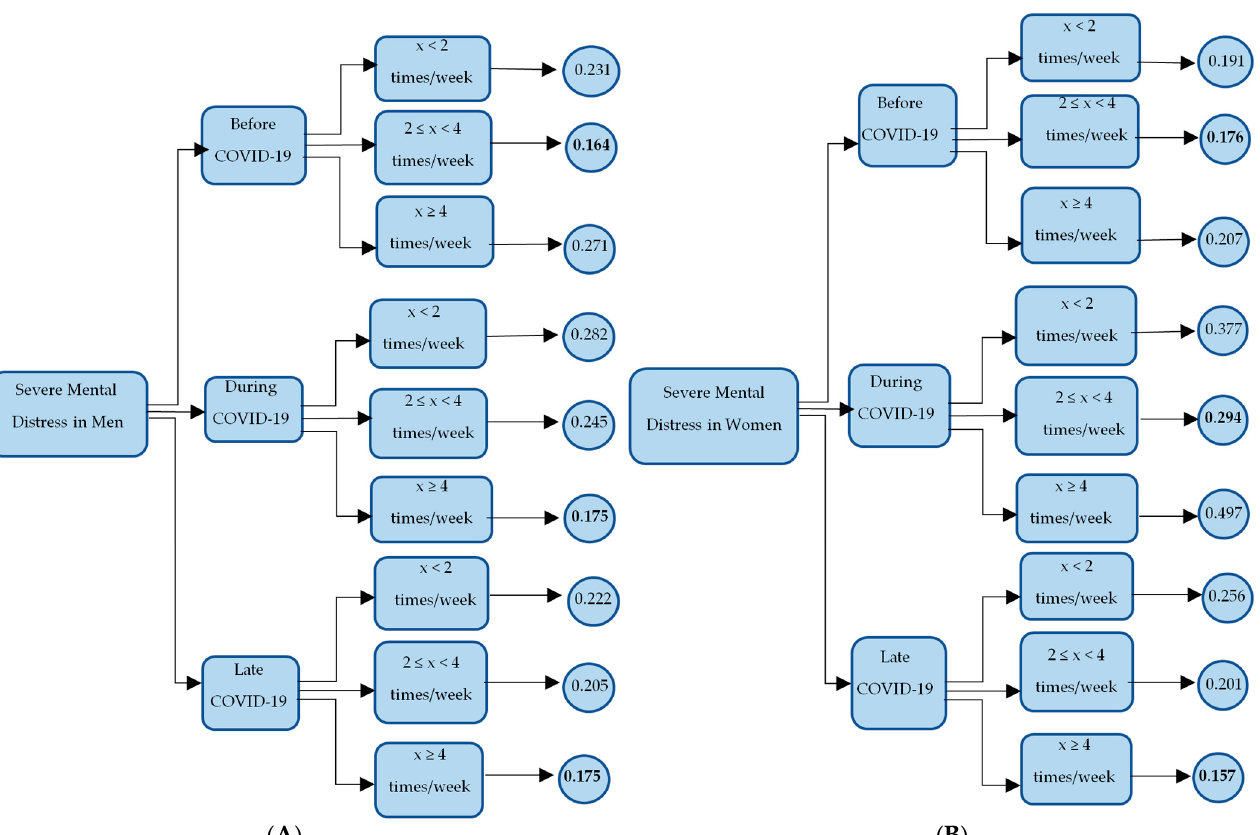
Figure 1. ( A )—Decision Tree of the adjusted margins (probability) for severe mental distress on men. ( B )—Decision Tree of the adjusted margins (probability) for severe mental distress on women. Bolded nodes represent the lowest probability and italic nodes represent the highest probability. During COVID-19: during lockdowns; After COVID-19: After COVID-19 ease of